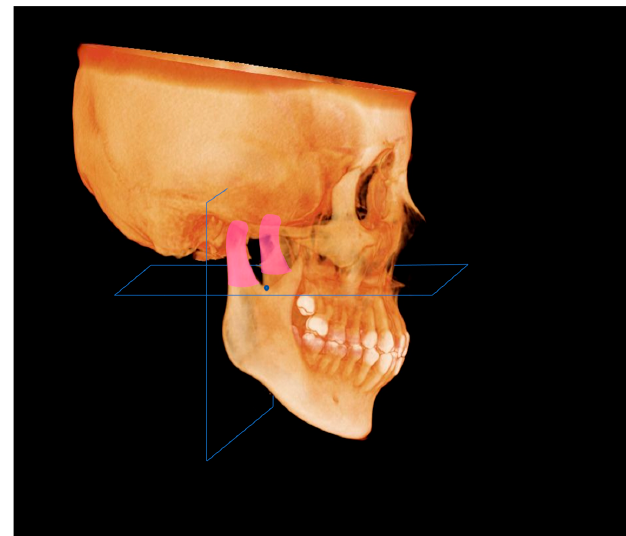
Figure 5. Volume of the condyle.